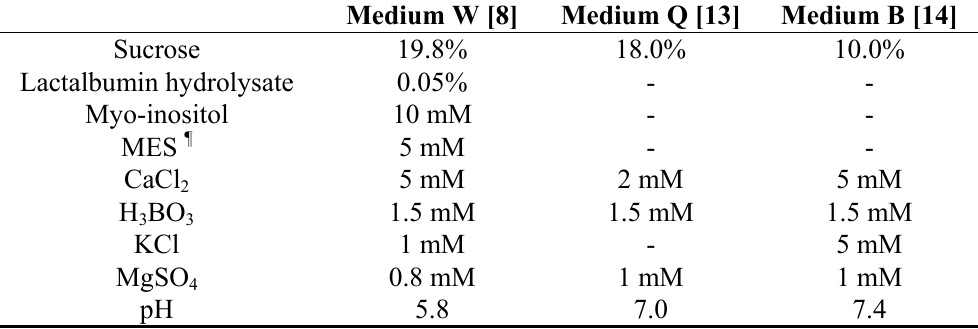
Table 1. Composition of the pollen germination media used in the present